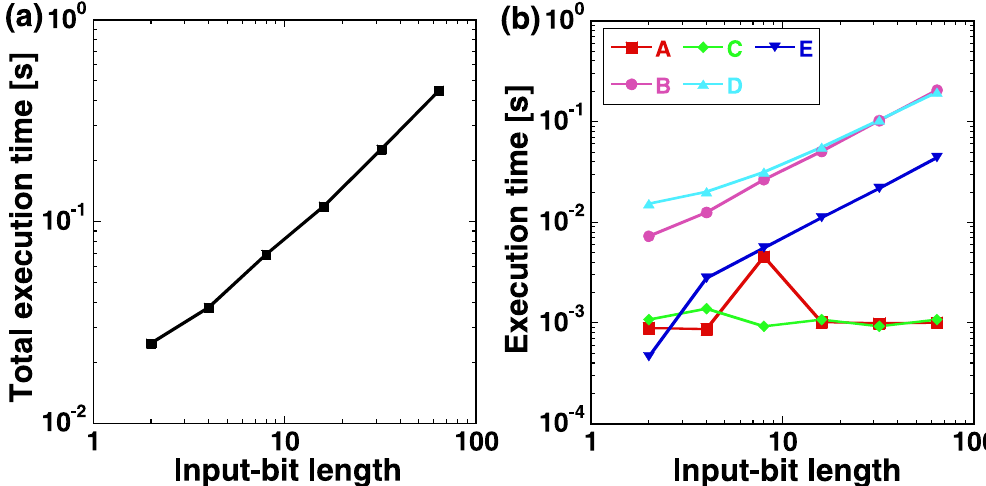
Figure 5. ( a ) Total execution time of secure comparison with garbled circuit for different input-bit lengths of 2-bit to 64-bit. ( b ) Execution time of each procedure for secure comparison. A (red squares): construction of logic circuit, B (pink circles): construction of garbled circuit, C (green diamonds): construction of Alice’s garbled input, D (light blue triangles): construction of Bob’s garbled input via oblivious transfer, and E (dark blue inverted triangles): execution of garbled